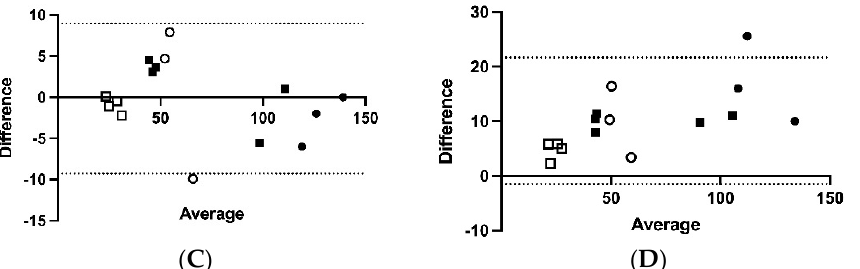
Figure 2. Bland–Altman plots showing the difference in ACTH concentrations (pg/mL) in samples kept at: ( A ) 4 °C versus 20 °C; ( B ) 4 °C versus 30 °C; ( C ) 4 °C versus 40 °C; and ( D ) 4 °C versus 70 °C in 15 horses. The solid lines represent the mean differences and the dotted lines represent the 95% level of agreement. Squares represent horses in which the basal ACTH concentration was determined and circles indicate horses in which the post-TRH stimulation ACTH concentration was determined. Hollow shapes represent non-PPID horses and solid shapes indicate horses with PPID.